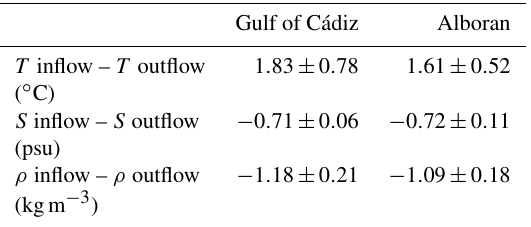
Table 3. Difference in the properties of the inflow and outflow at the boundaries of the